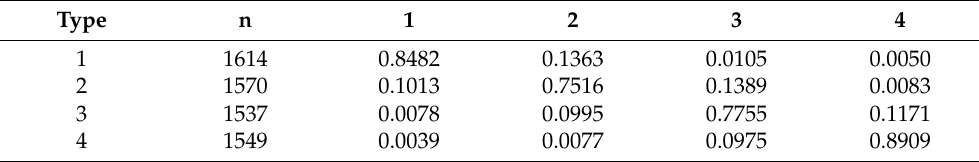
Table 4. Traditional Markov chain transition probability matrix for